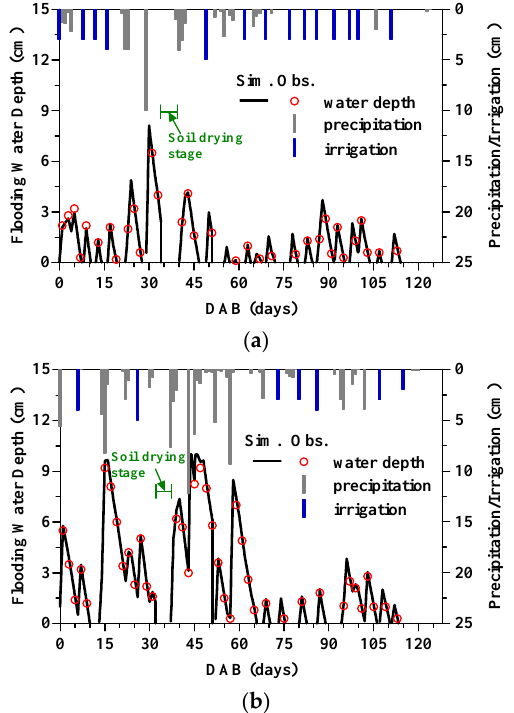
Figure 3. Observed (points) and simulated (lines) flooding water depths during the 2008 ( a ) and 2009 ( b ) seasons.